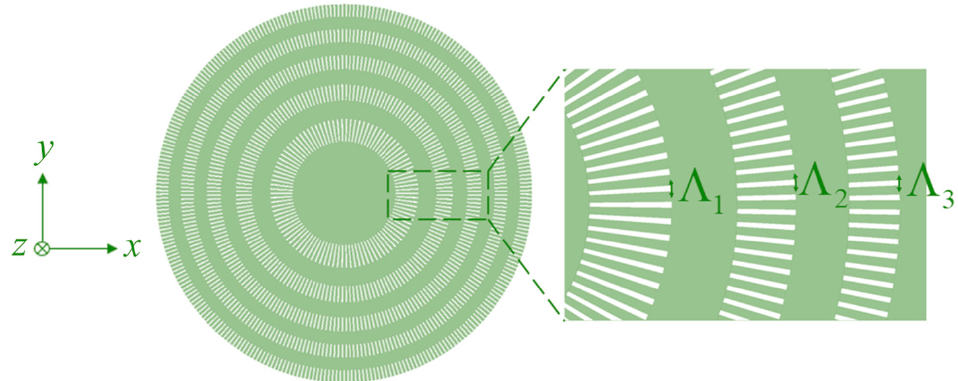
Figure 3. Top-view diagram of our proposed polarization-independent binary phase Fresnel zone plate using subwavelength gratings (SWGs). The duty cycles of the SWGs are constant at a given zone.